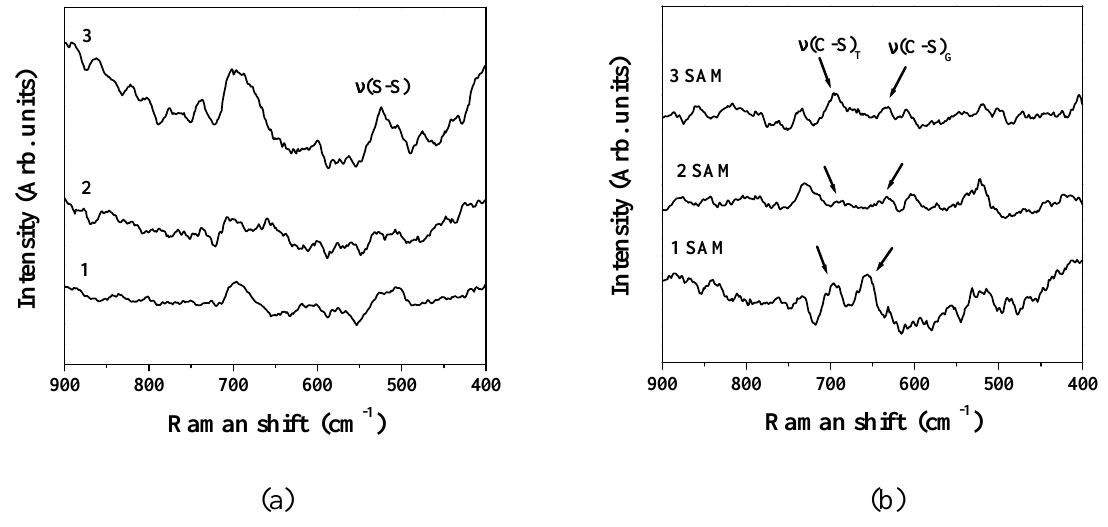
Figure 5 . SERS spectra of phenylboronic acid monolayers excited at 488 nm (25 ℃ ); (a) Bulk solid and (b) Phenylboronic acid SAMs on